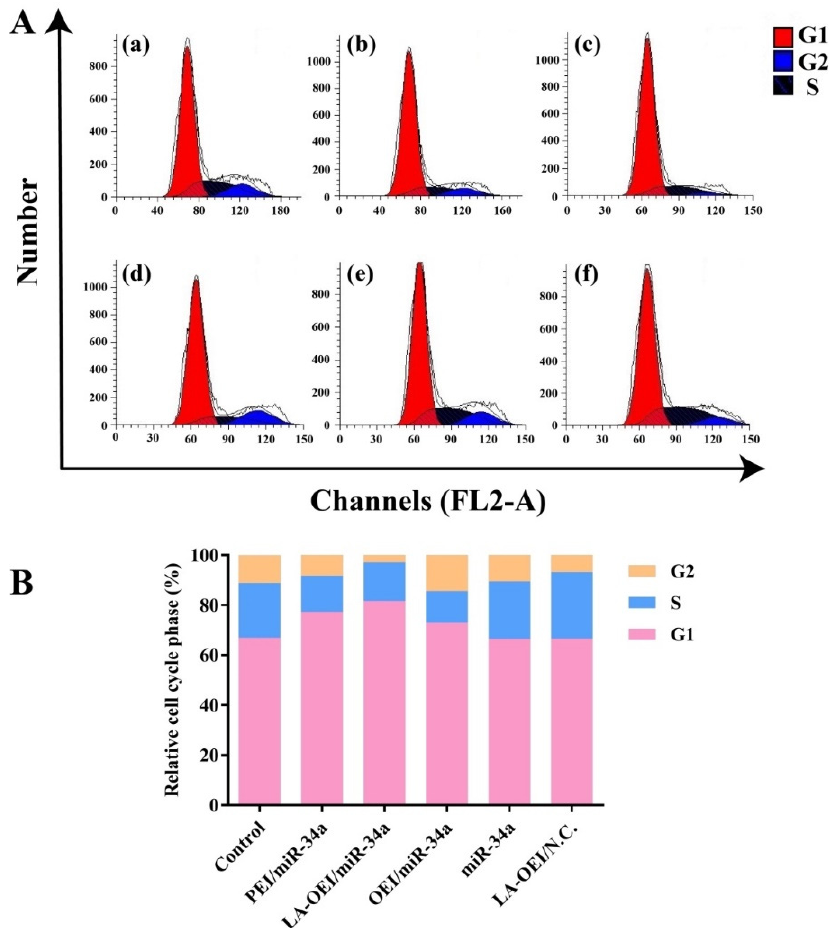
Figure 7. The cell cycle arrest analysis of HeLa cells after miR-34a transfection. ( A ) the cell cycle analysis of HeLa cells induced by different nanoparticles using FACS: ( a ) control, ( b ) PEI/miR-34a, ( c ) LA-OEI/miR-34a, ( d ) OEI/miR-34a, ( e ) miR-34a and ( f ) LA-OEI/N.C. ( B ) Quantitative analysis of the cell cycle.